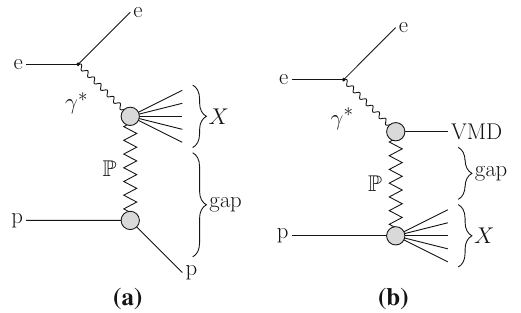
Fig. 3 The two diffractive systems available for resolved photopro- duction: either the proton is elastically scattered and the photon side contains the diffractive system ( a ), or the vector meson is elastically scattered and the proton side contains the diffractive system ( b